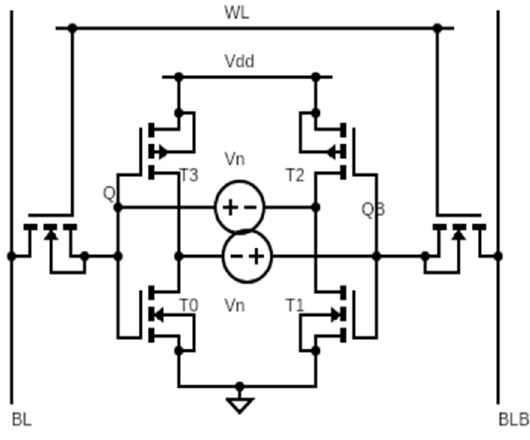
Figure 9. SRAM cell including two random noise voltage sources.